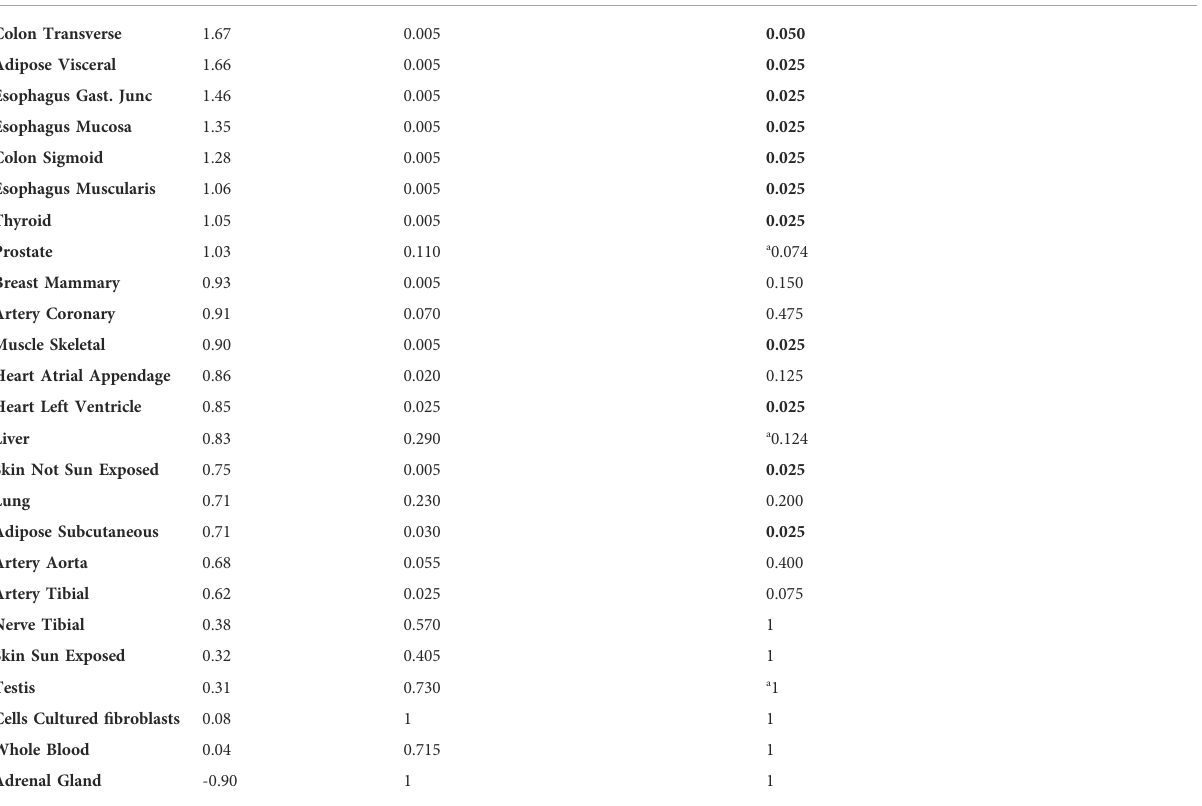
TABLE 2 In fl uence of IC on clock correlation structure across tissues. Twelve core circadian clock genes have a well conserved signature correlation matrix in healthy mammalian tissue.